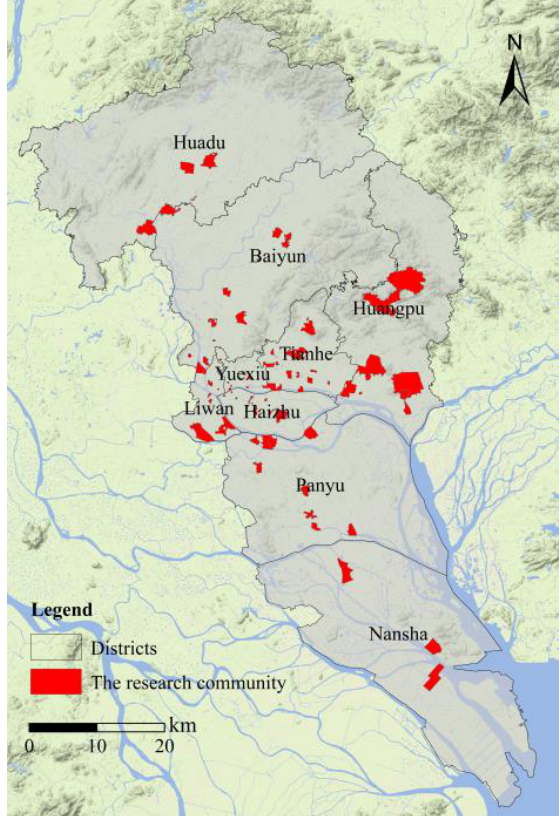
Figure 1. Communities that participated in the questionnaire across Guangzhou.